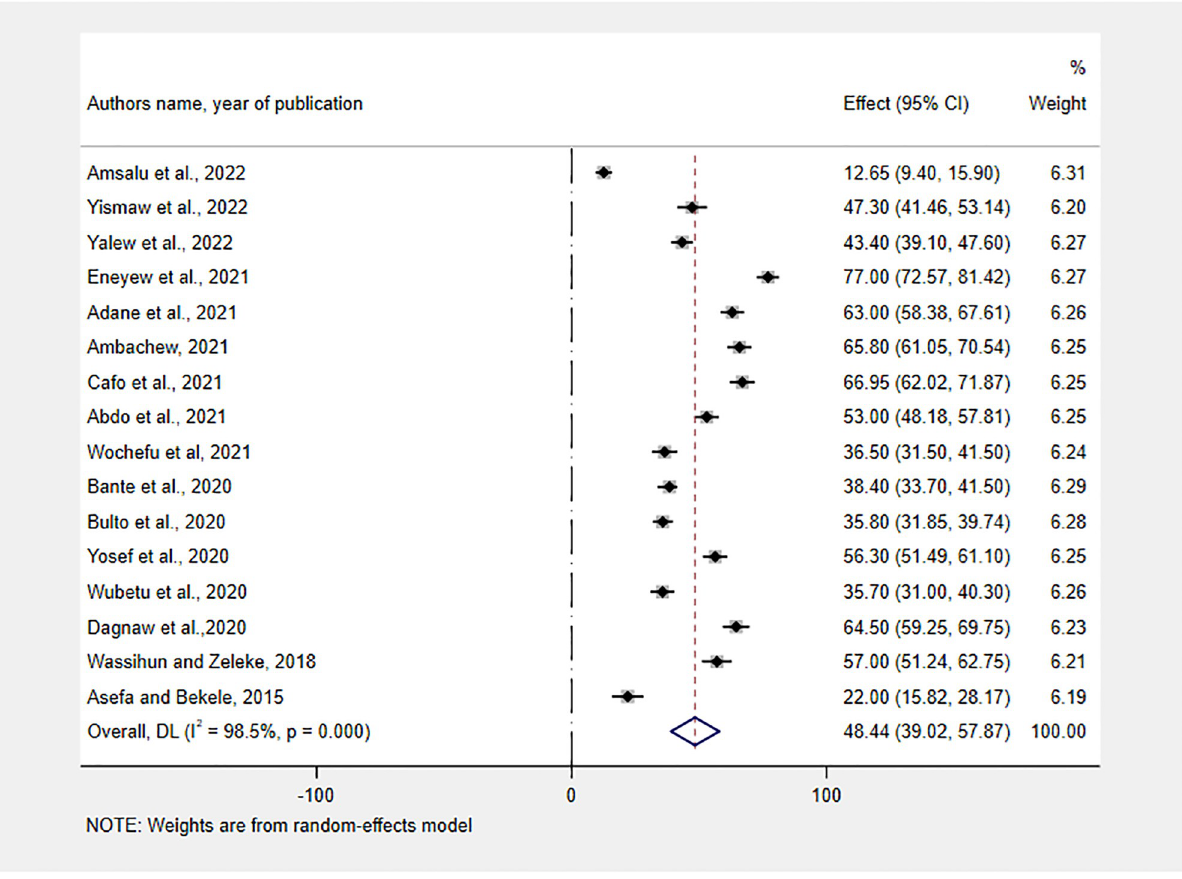
Fig 2. Forest plot showing the pooled estimates of RMC in Ethiopia,